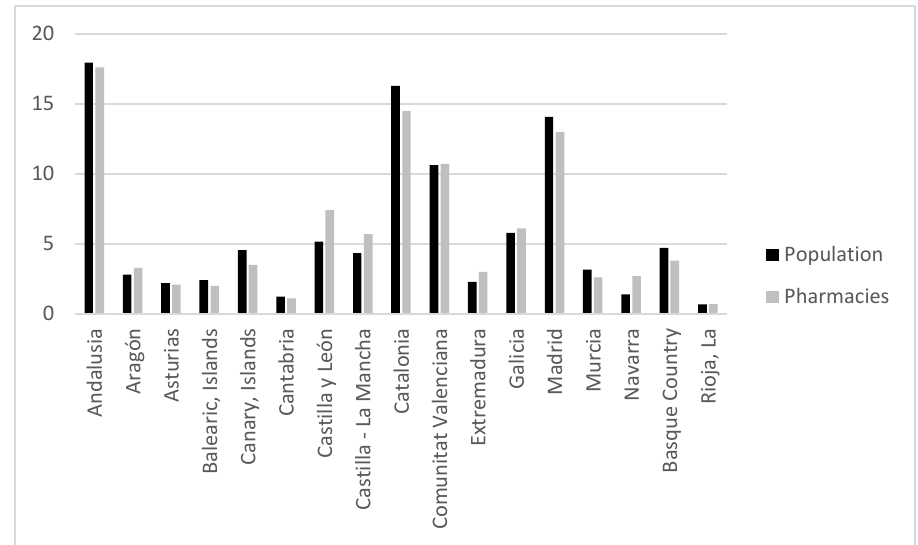
Figure 2. Percentage of the number of inhabitants and pharmacies of each of the autonomous regions over the total of Spain. Source: Authors’ own work based on data provided by the General Council of Official Associations of Pharmacists, 2019.